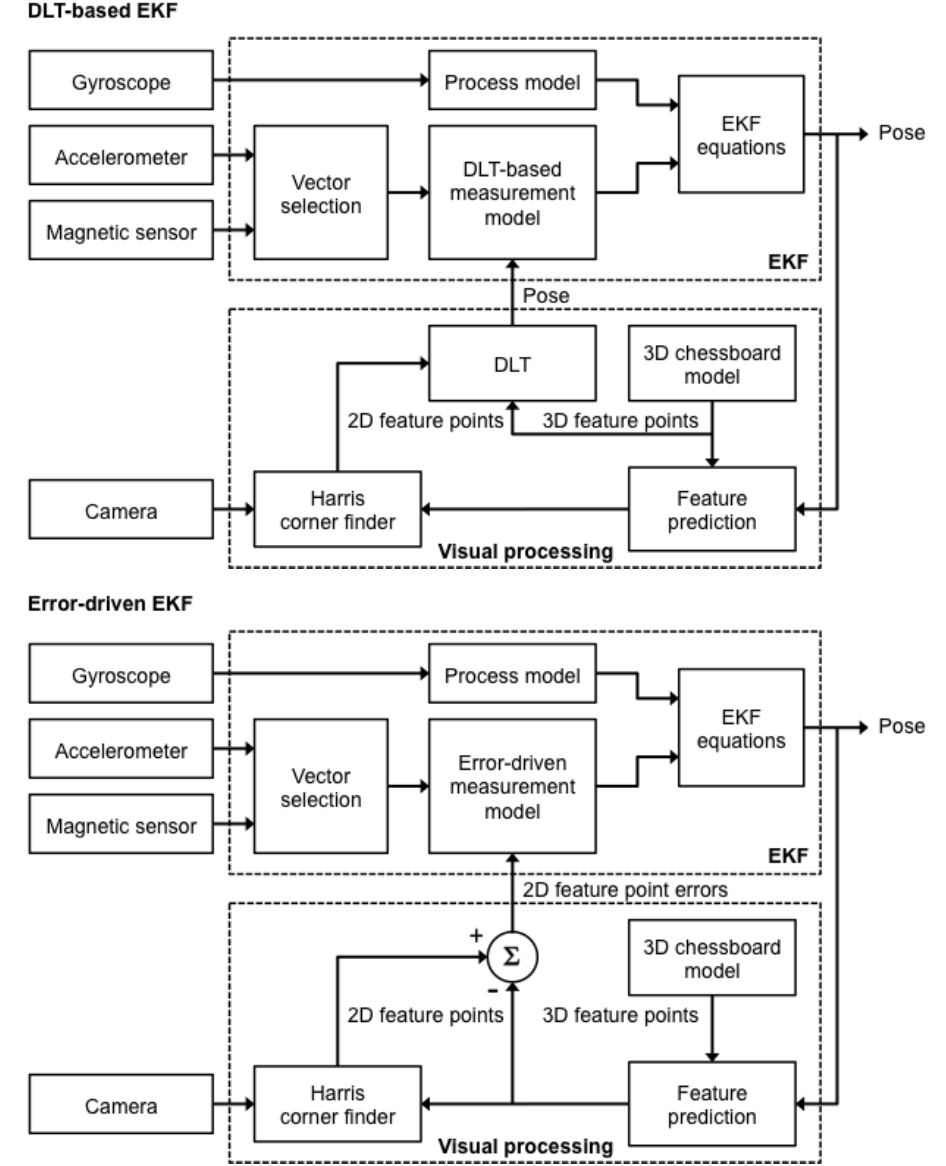
Figure 3. Block diagrams of the two Kalman-filter-based methods of sensor